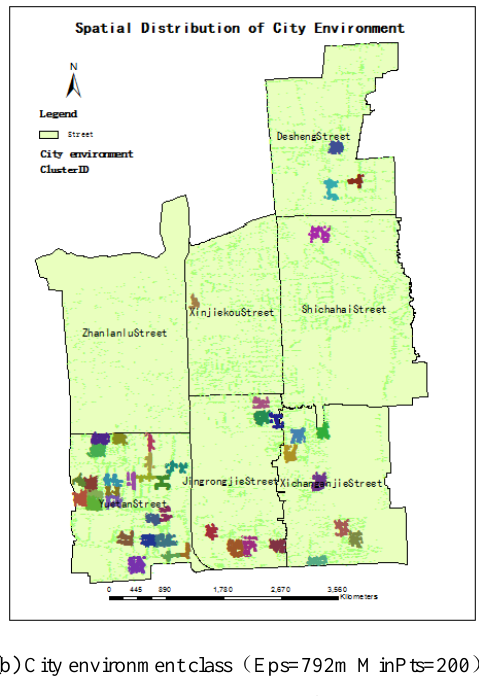
Figure6. Spatial distribution of cluster